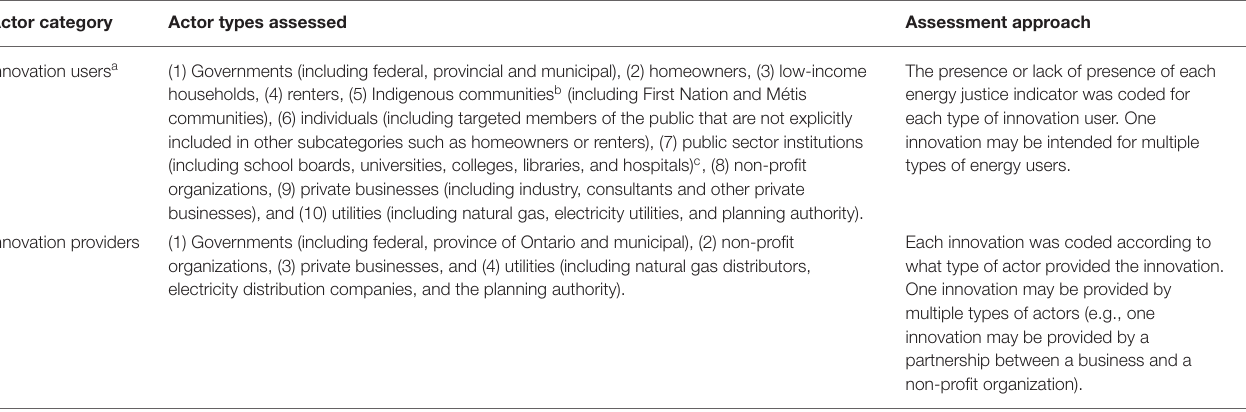
TABLE 3 | Various actors involved within the Ontario ETIS innovation system. Actor